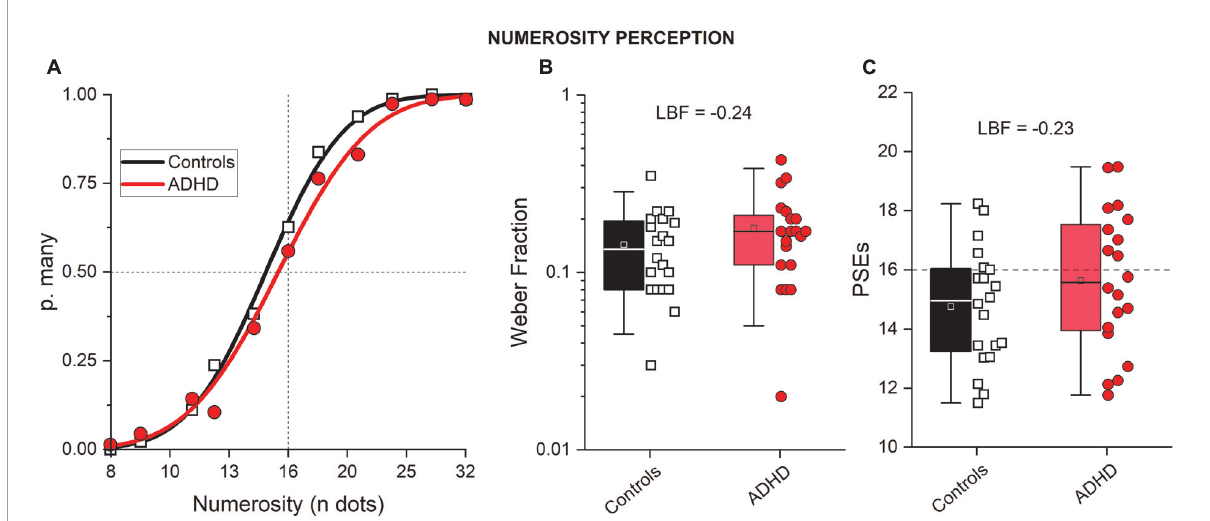
FIGURE4 Numerosity perception. (A) Psychometric functions (aggregate data) reporting the probability of “many” (p. many) responses as a function of the test numerosity divided for controls (black, squares) and participants with ADHD (red, circles). (B,C) Whisker plots reporting numerosity thresholds (Weber fractions, B ) and accuracy (PSEs, C ). Color conventions as before. Whisker parameters. Box: 25–75 percentiles; Whisker: 5–95 percentiles; Line: average; Square: median.